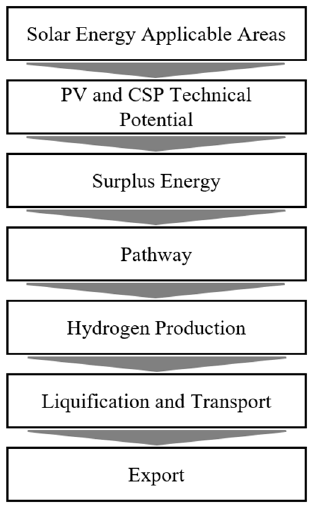
Table 1. UAE’s results for solar energy applicable areas for 25 km and 40 km scenarios. Figure 2. Study flow Figure 2. Study flow chart.